Question: Is the quantity shown trending increasing or decreasing?
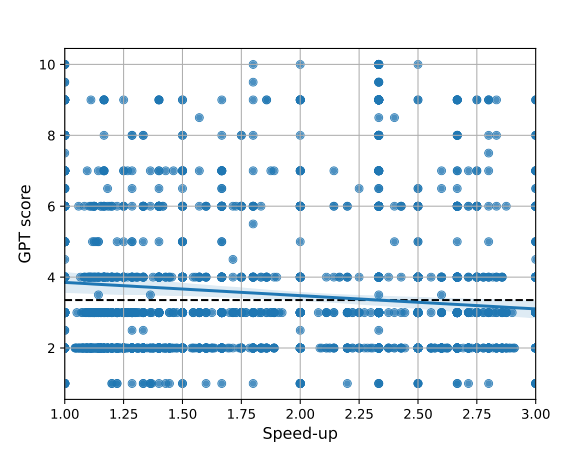
Answer: increasing